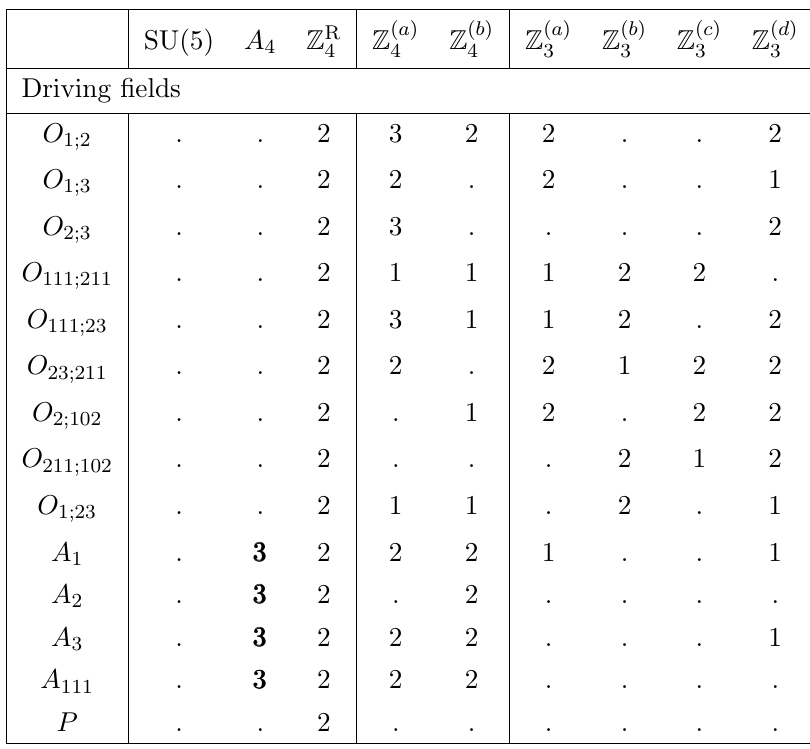
Table 4 . The driving (cid:12)eld content of our model. A dot means that the (cid:12)eld is an invariant singlet under the respective symmetry. Note, that only one P (cid:12)eld is shown here. Indeed one has to introduce as many P (cid:12)elds as operators to (cid:12)x the phases of the (cid:13)avon (cid:12)elds, as described in section